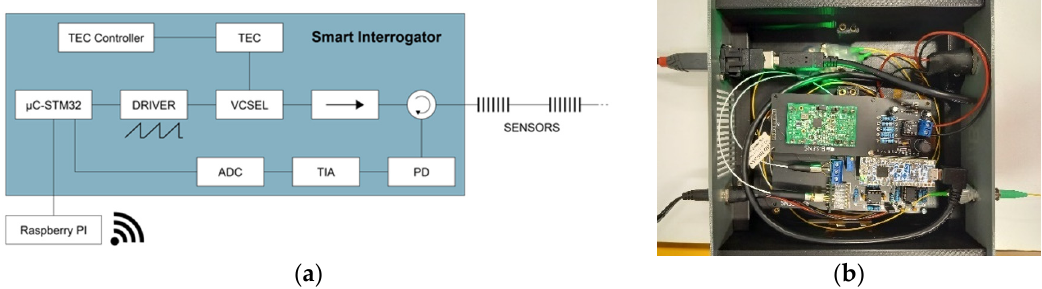
Figure 1 . ( a ) Scheme of the developed smart interrogator; ( b ) picture of the developed printed circuit board for the smart interrogator. board for the smart